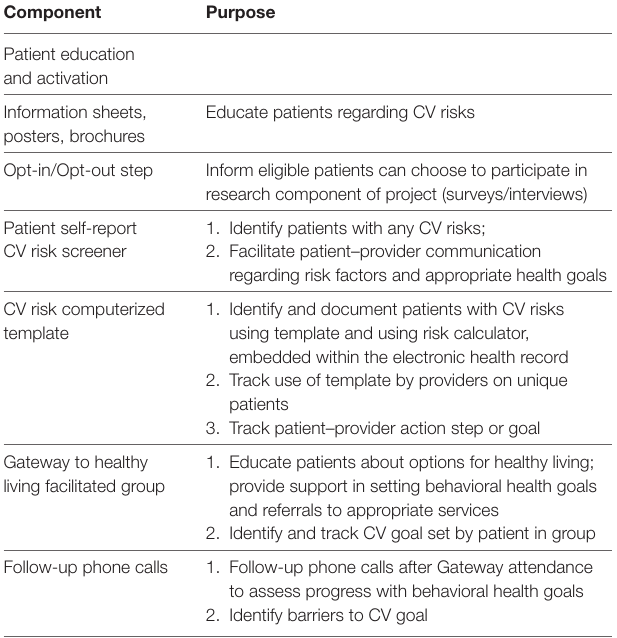
tABle 1 | Summary of Cardiovascular (CV) Toolkit